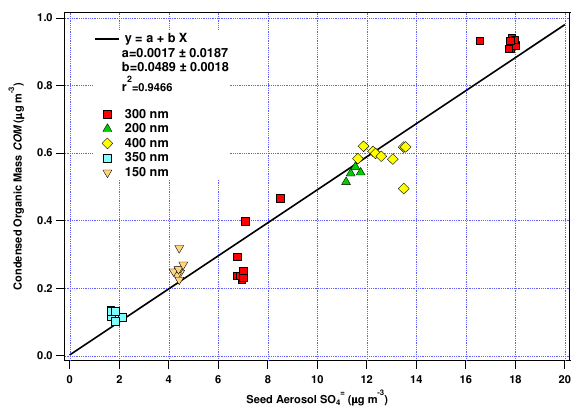
Figure 2. The condensed organic mass ( COM ) on neutral sulfate seed particles. It is approximately a linear function of the available sulfate particle mass regardless of particle Fig. 2. The condensed organic mass (COM) on neutral sulfate seed sizes. particles. It is approximately a linear function of the available sul- fate particle mass regardless of particle